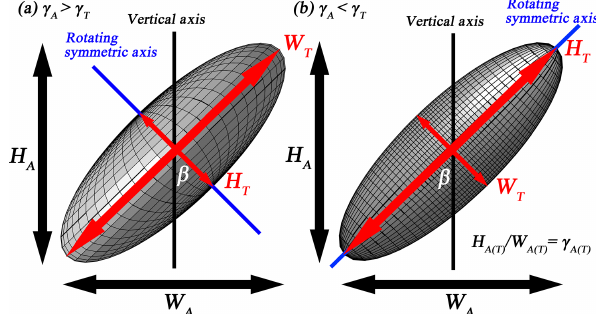
various values of V T and β would likely be observed. The